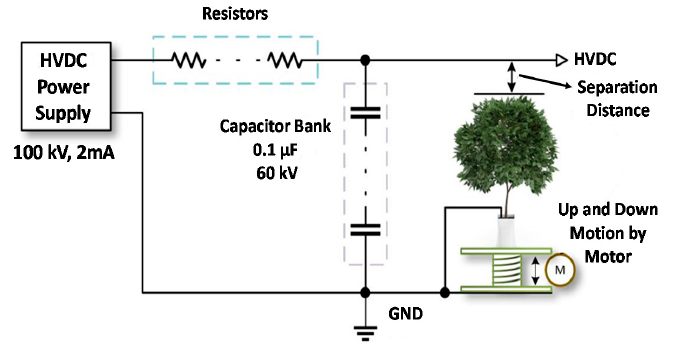
Figure 1. Experimental configuration.